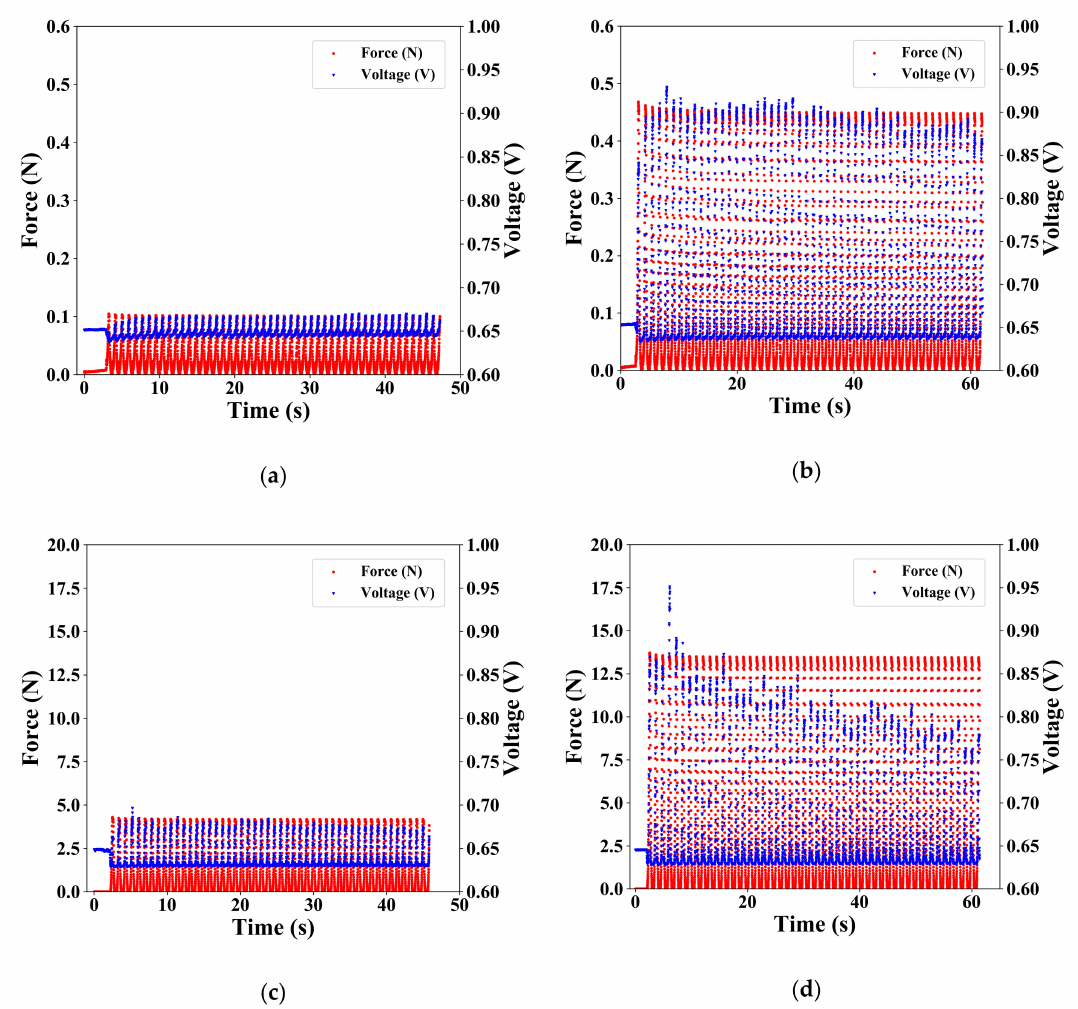
Figure 7. Results of the response for pulsed input: ( a , b ) soft-MPS (soft) and ( c , d ) soft-MPS (hard) at a pushing depth of ( a , c ) 0.5 mm and ( b , d ) 0.75